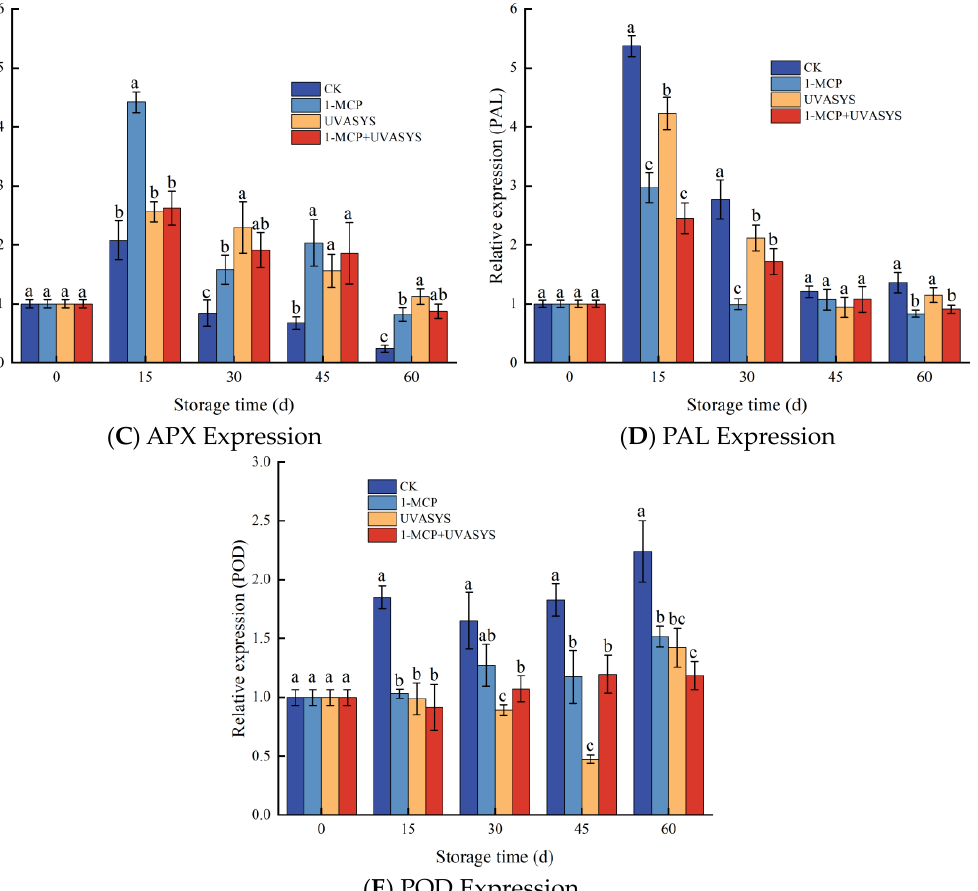
Figure 8. Effects of 1-MCP and UVASYS on SOD ( A ), PPO ( B ), APX ( C ), PAL ( D ) and POD ( E ) A graph showing the expression of bamboo shoots over time. Each point represents the average ± standard error ( n = 3). Different letters indicate significant differences among treatments for each sampling time at p < 0.05.